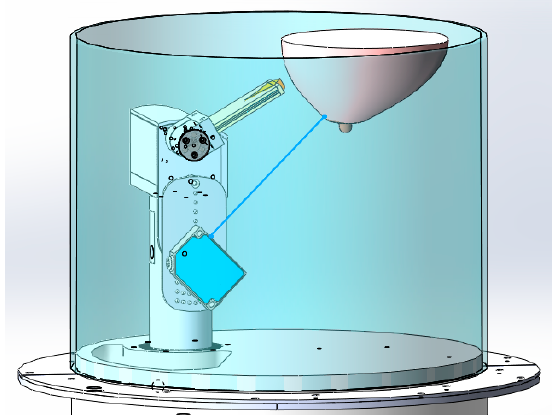
Figure 3. Diagram of the positioning arm in the imaging tank with the antenna and laser attached.